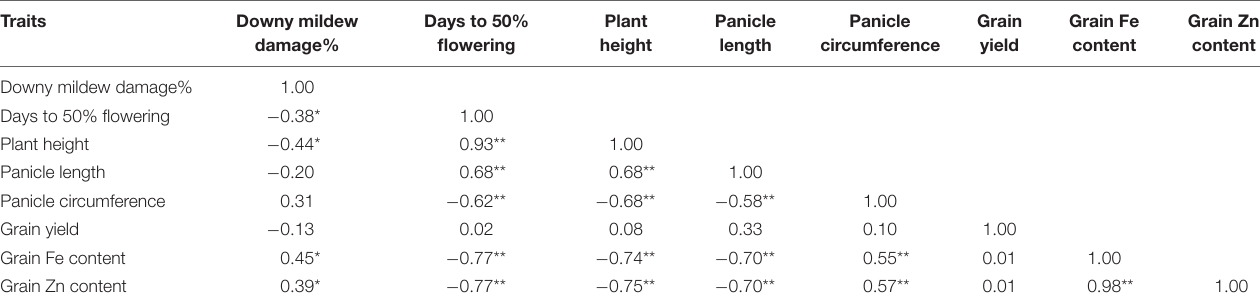
TABLE 6 | Association of agronomic and morphological traits of pearl millet ( Pennisetum glaucum L.) across locations in West Africa.